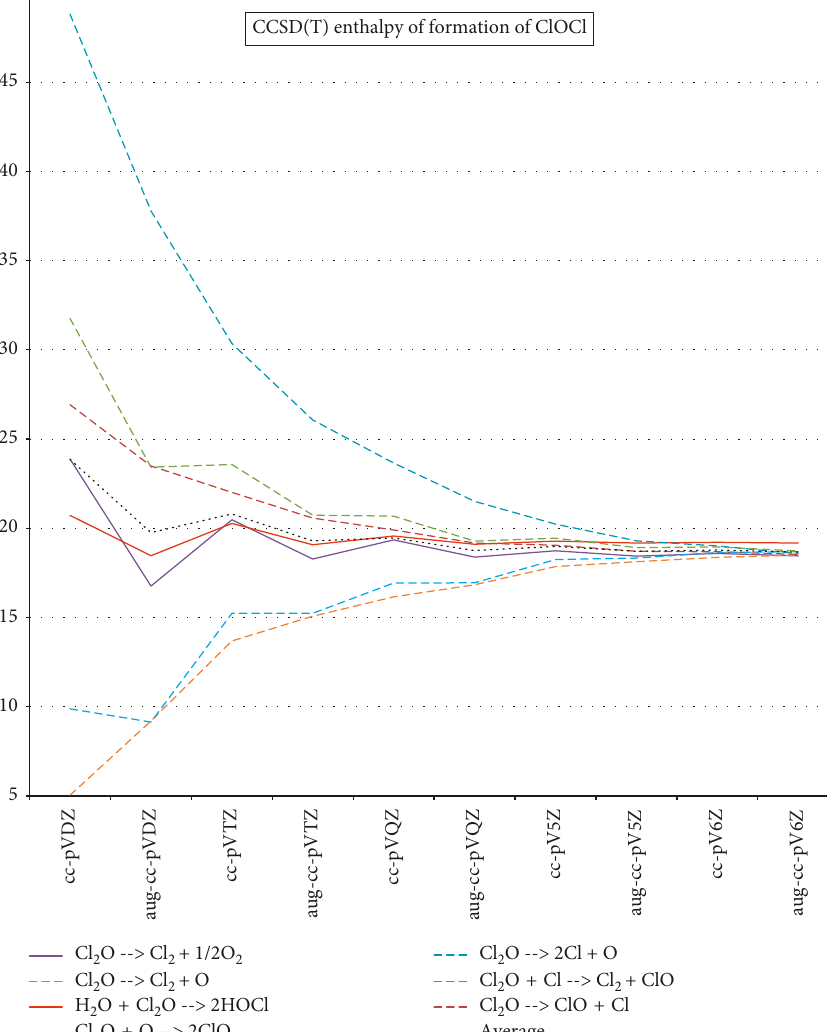
Figure 10: CCSD(T) calculation of the enthalpy of formation of Cl 2 O (in kcal/mol) using different basis sets and reactions. Full lines refer to reactions between closed-shell molecules. Dashed lines are the results for reactions involving radicals. The dotted black line is the average for all the reactions for each basis